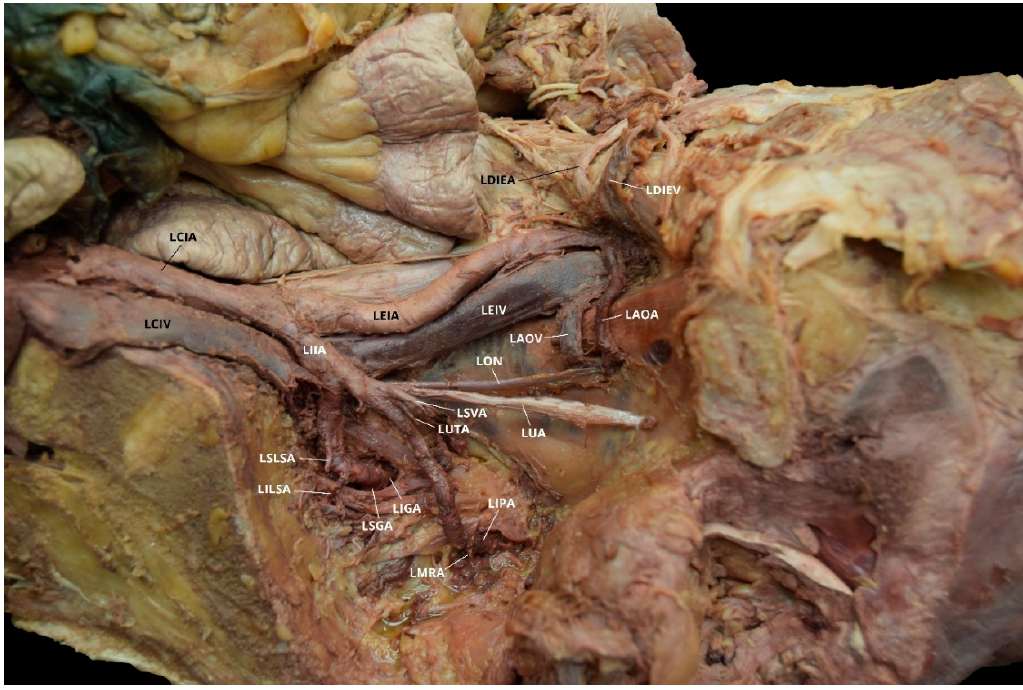
Figure 6. Facilitated display highlighting the left internal iliac artery branches with the left aberrant obturator artery for Case 4. LAOA = Left Aberrant Obturator Artery; LAOV = Left Aberrant Obturator Vein; LCIA = Left Common Iliac Artery; LCIV = Left Common Iliac Vein; LDIEA = Left Deep Inferior Epigastric Artery; LDIEV = Left Deep Inferior Epigastric Vein; LEIA = Left External Iliac Artery; LEIV = Left External Iliac Vein; LIGA = Left Inferior Gluteal Artery; LIIA = Left Internal Iliac Artery; LILSA = Left Inferior Lateral Sacral Artery; LIPA = Left Internal Pudendal Artery; LMRA = Left Middle Rectal Artery; LON = Left Obturator Nerve; LSGA = Left Superior Gluteal Artery; LSLSA = Left Superior Lateral Sacral Artery; LSVA = Left Superior Vesical Artery; LUA = Left Umbilical Artery; LUTA = Left Uterine Artery. The Left Iliolumbar Artery (LILA) and the Left Vaginal Artery are not pictured.